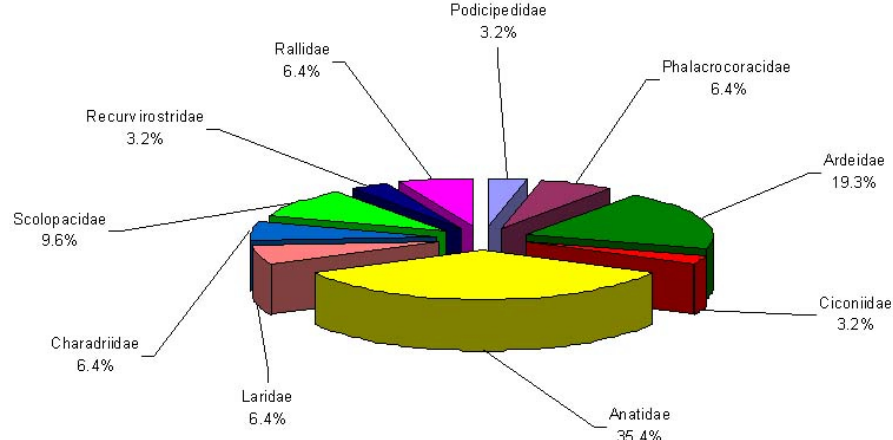
Figure 1. Proportion of avian families as represented by species richness of waterbirds of Hathnikund